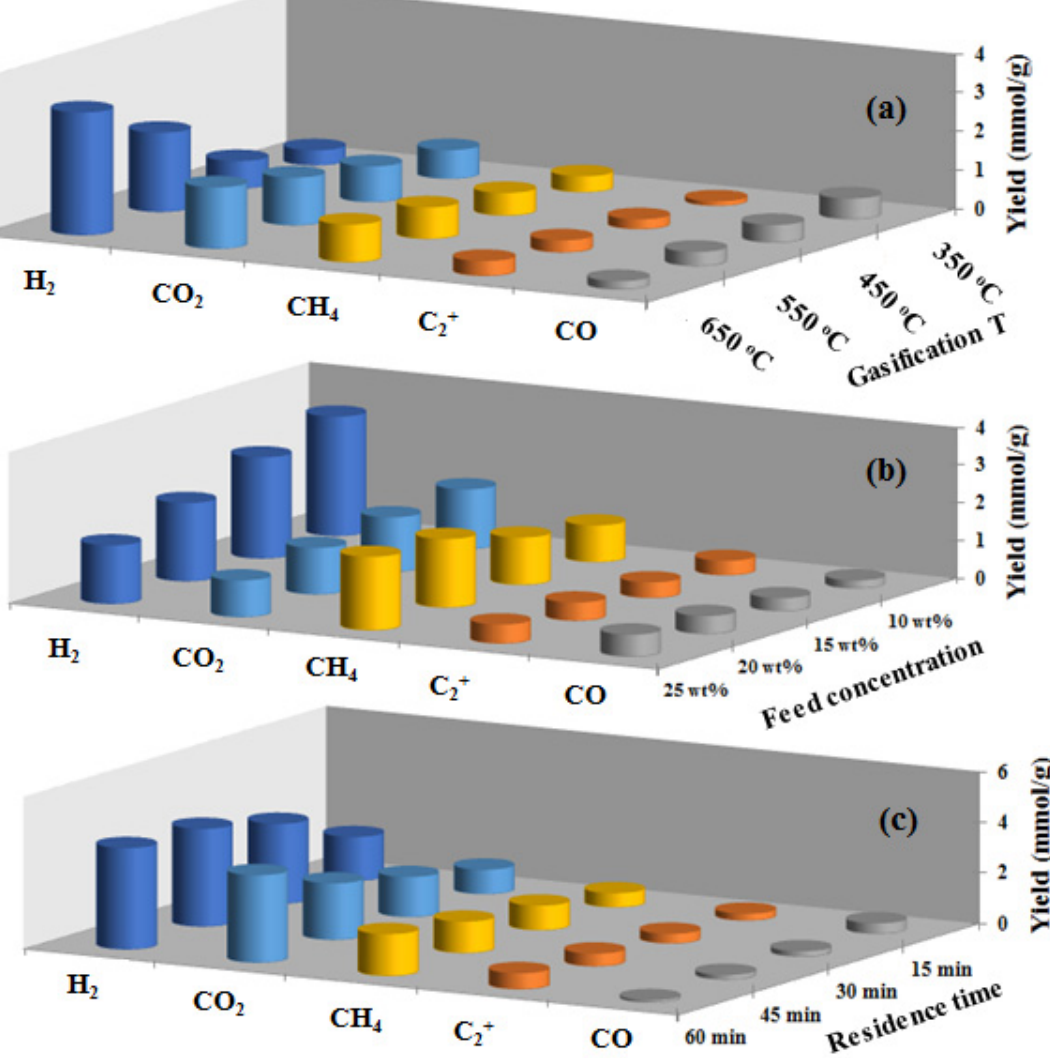
Figure 5. ( a ) Effect of temperature on the gas yields from SCWG of a canola hull at 10 wt% feed concentration and 30 min of residence time. ( b ) Effect of feed concentration on the gas yields from SCWG of a canola hull at 650 °C and 30 min of residence time. ( c ) Effect of residence time on the gas yields from SCWG of canola hull at 650 °C and 10 wt% feed concentration The data presented in an average of replicate measurements with a standard error of less than 3.5%.